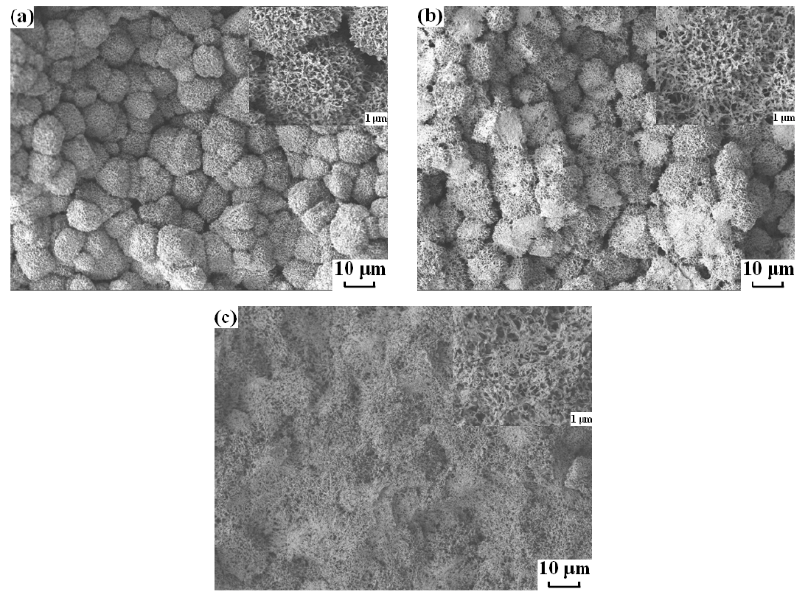
Figure 6. Scanning electron microscopy (SEM) photographs of cross-sections of PVDF membranes prepared by quenching PVDF/dialkyl phthalate solutions into ice-water: ( a ) PVDF/DMP, ( b ) PVDF/DEP and ( c ) PVDF/DBP.